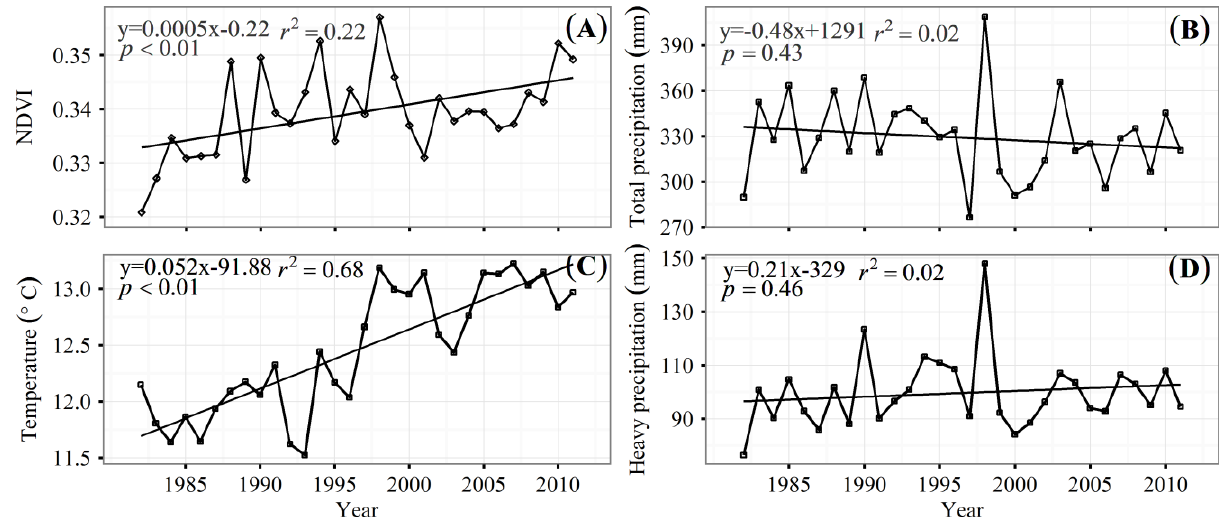
Figure 2. Dynamics of mean growing season (April–October) NDVI ( A ); annual precipitation ( B ); mean growing season temperature ( C ); and heavy precipitation ( D ) over northern China during the period 1982–2011. Straight lines indicate linear regressions of NDVI, precipitation, temperature and heavy precipitation against the time period, respectively.